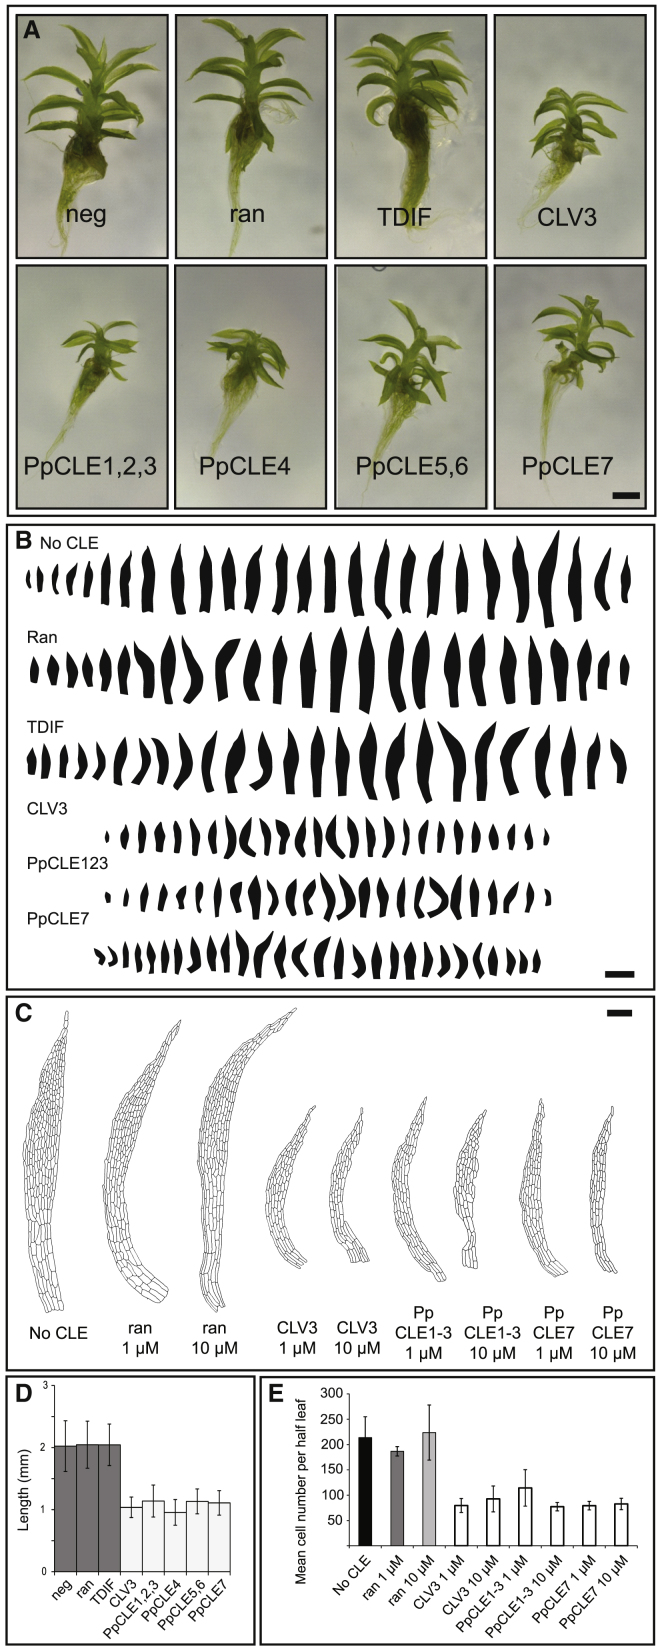
Physcomitrella CLEs Suppress Cell Proliferation(A) Treatment of Physcomitrella plants with 1 μM CLV3-like CLEs from Arabidopsis and Physcomitrella, but not TDIF-like CLEs, causes gametophore and leaf stunting. The scale bar represents 100 μm.(B) Leaf series from gametophores treated with CLEs expressed during gametophore development. The scale bar represents 1 mm.(C) Cell outlines of half-leaves in CLE-treated gametophores (leaf 9 was used). The scale bar represents 100 μm.(D) Height measured from ≥25 gametophores treated with CLEs (n ≥ 25; ANOVA; Tukey’s HSD; p < 0.005).(E) Leaf 9 cell numbers in CLE-treated half-leaves (n = 3; ANOVA; Tukey’s HSD; p < 0.05).See also Figure S7.